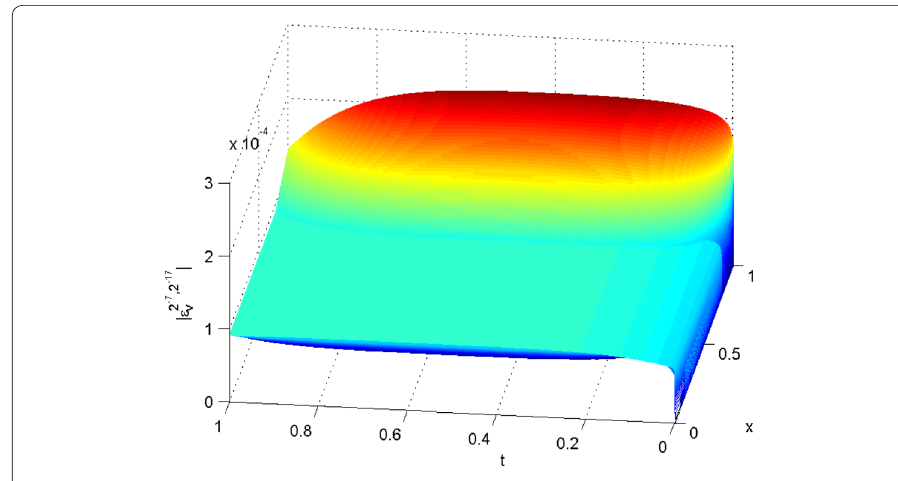
2–7,2–17 | = | (cid:11) v – v | when h = 2 –7 , and τ = 2 –17 for Example 2 v